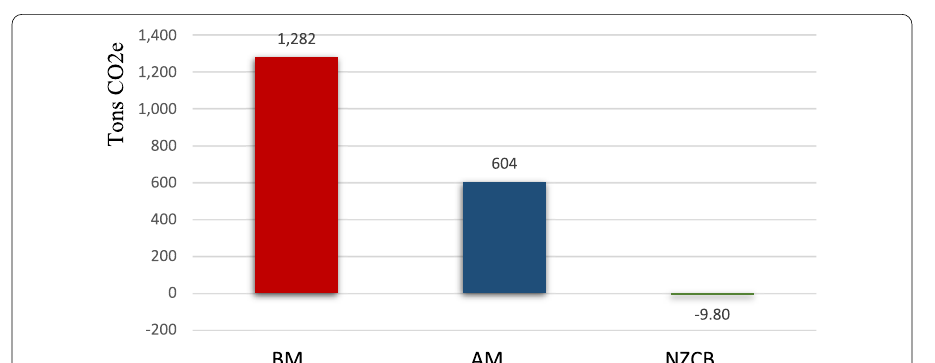
Fig. 17 Total carbon emissions over LCA for 3 models